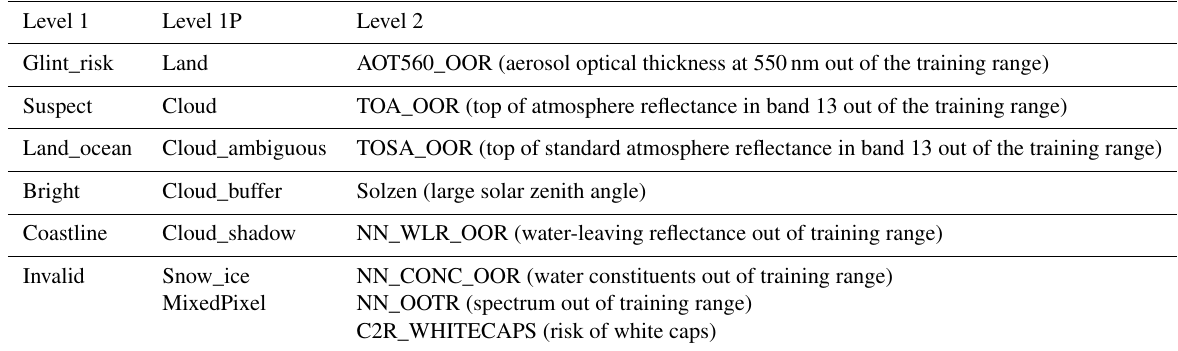
Table 1. Flags of excluded pixels.